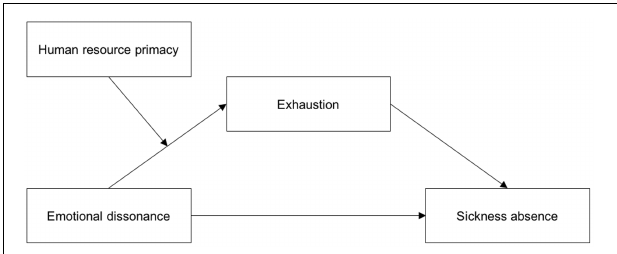
FIGURE 1 | A graphical conceptual overview of the moderated mediation